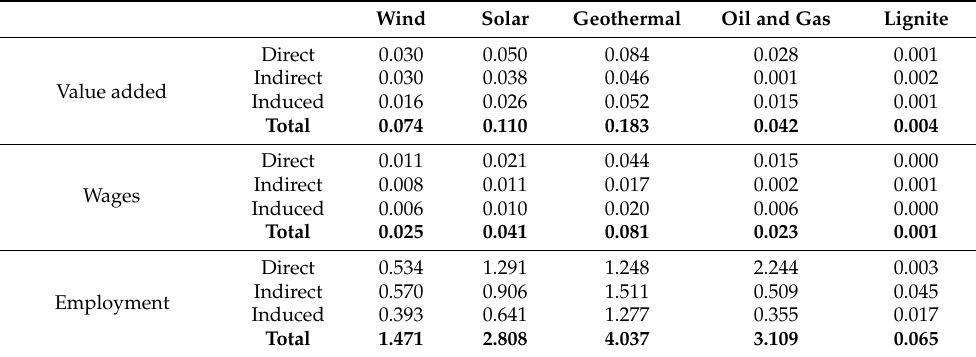
Table 6. Standard deviation metrics of demand vector multiplier